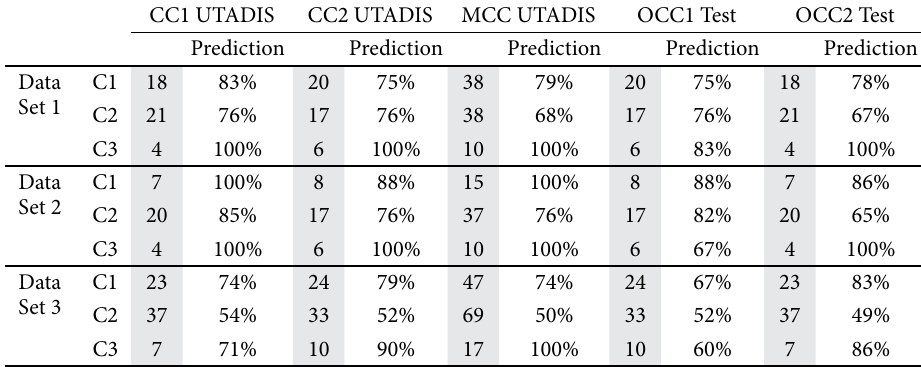
table 9. Prediction and explanation abilities of the models for data